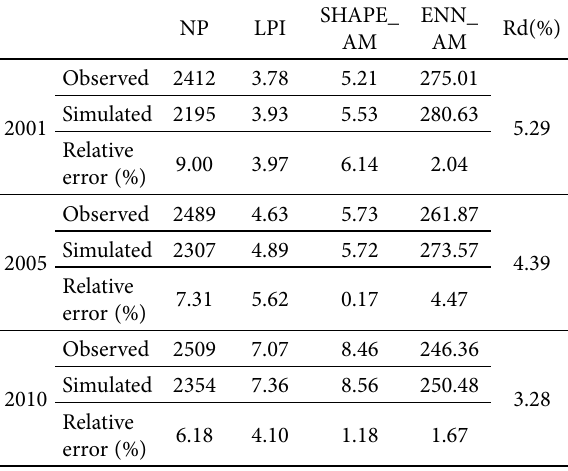
Table 3. Comparison between observed and simulated landscape metrics values for 2001, 2005, and